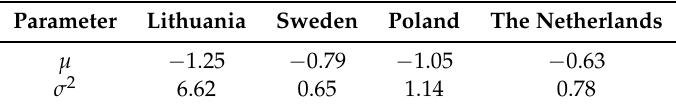
Table 4. Estimated Random Walk with Drift (RWD) parameters of time series κ ( t ) derived from the re-fitted Poisson regression.